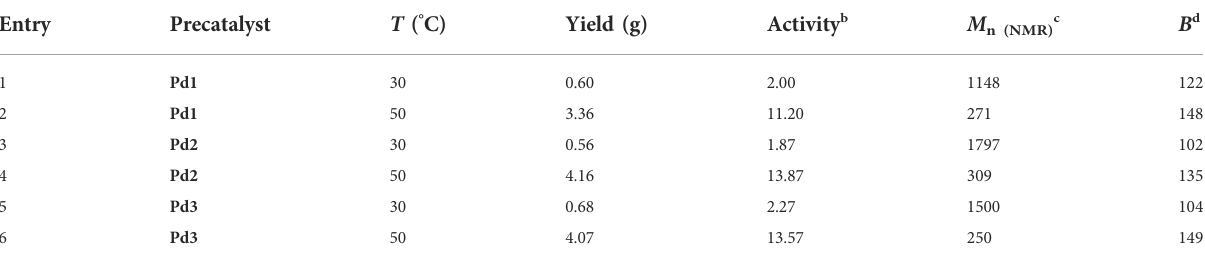
TABLE 2 Pd(II) catalysts for ethylene oligomerization a